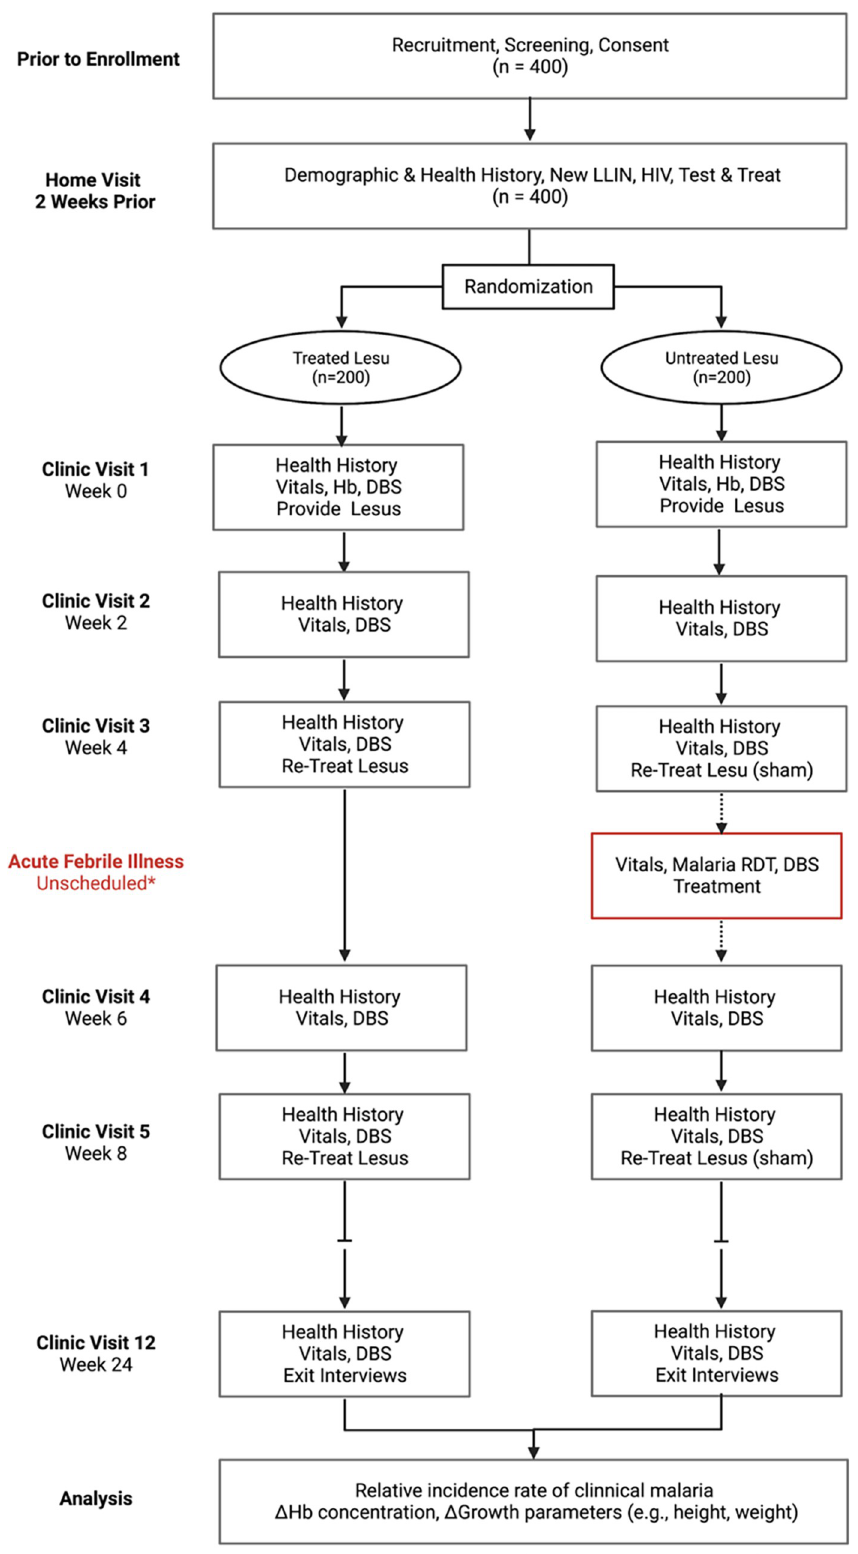
Fig 1. Overview of study schema with example of acute visit in the control group. https://doi.org/10.1371/journal.pone.0284322.g001 PLOS ONE | https://doi.org/10.1371/journal.pone.0284322 April 27,